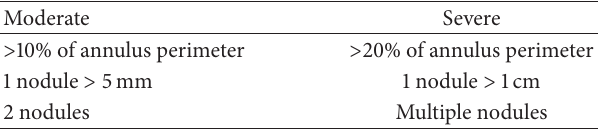
Table 2: Aortic annulus calcium classification of